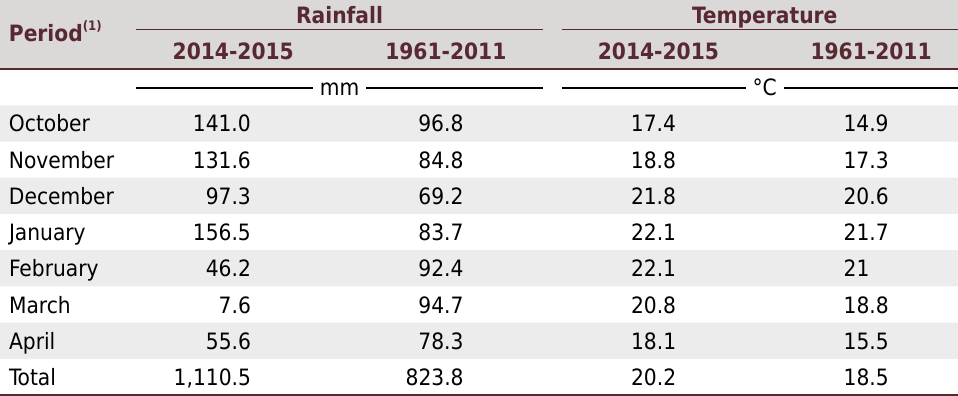
Table 4. Monthly weather values during the period studied Period